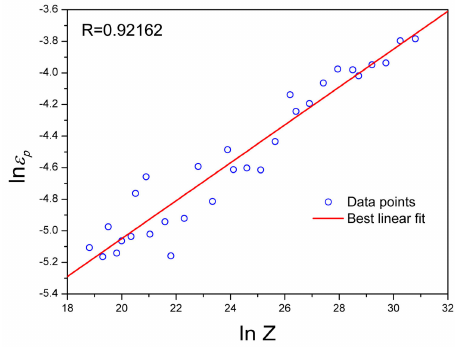
Figure 3. Relation between peak strain and Zener–Hollomon parameter.